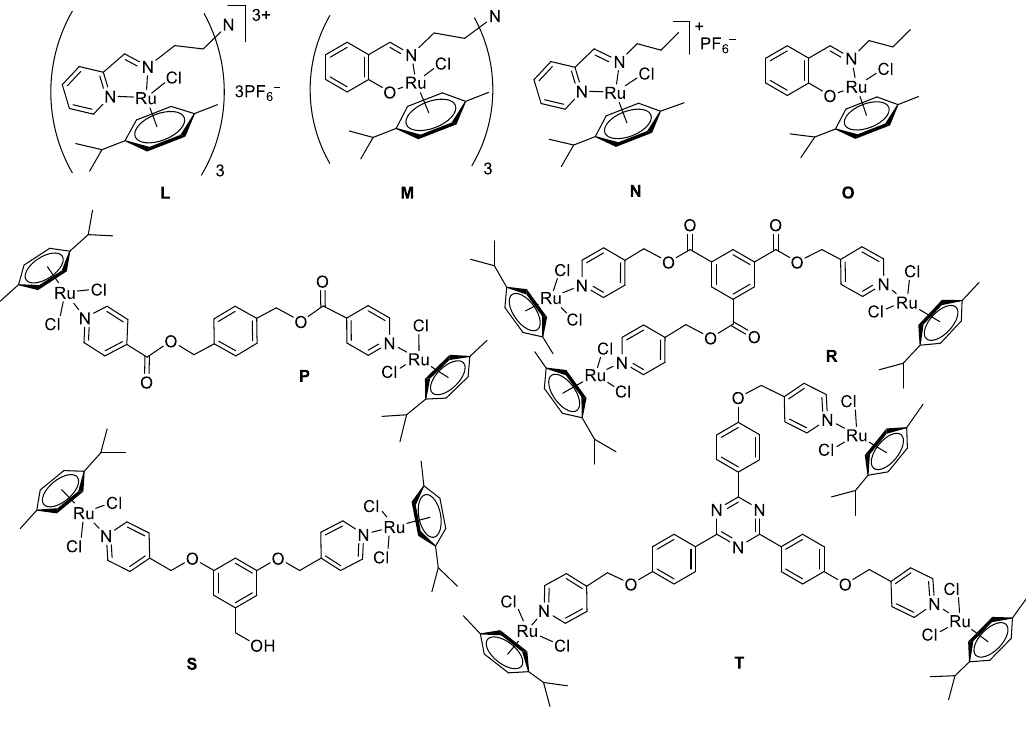
Figure 3. Structure of star-shape trinuclear L and M , and of the mononuclear N and O Ru(II)-p- cymene complexes with Schiff-base ligands; structure of di- ( P and R ) and trinuclear ( S and T ) ruthenium(II)- p -cymene complexes with polypyridyl ester and ether ligands.